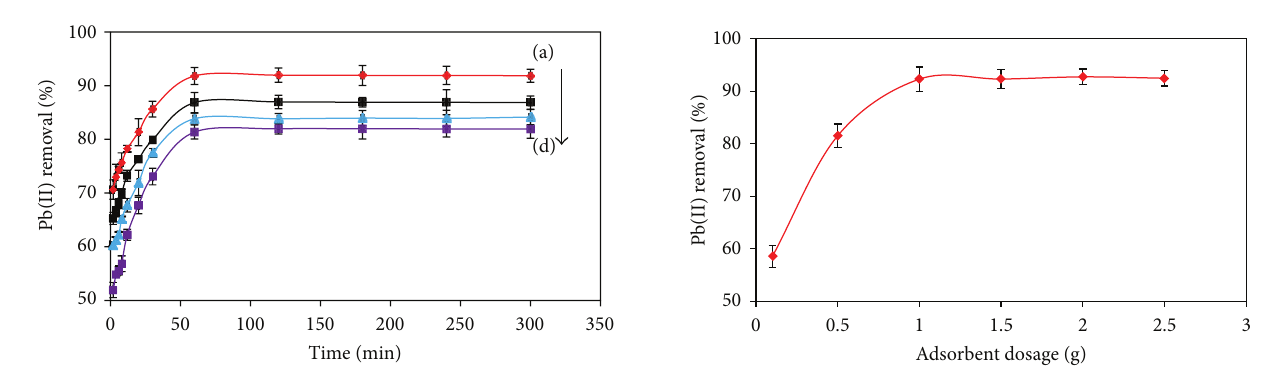
Figure 3: Effects of agitation time on lead ions removal (concentra- tions: a to d: 10mg/L to 50 mg/L; adsorbent dosage: 1.2g; pH: 5.4; error bar = ± S.D.; and 𝑛 = 3 ).